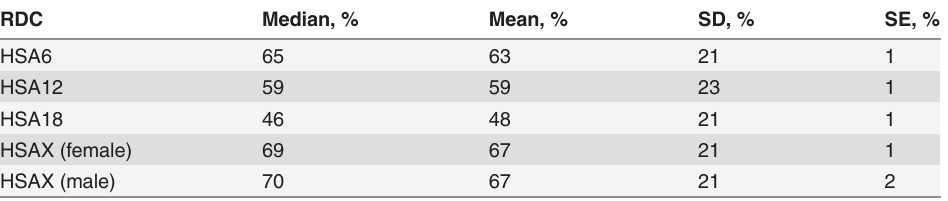
Table 1. Statistical characteristics of RDCs of the HSA6, HSA12, HSA18 and HSAX. RDC Median,